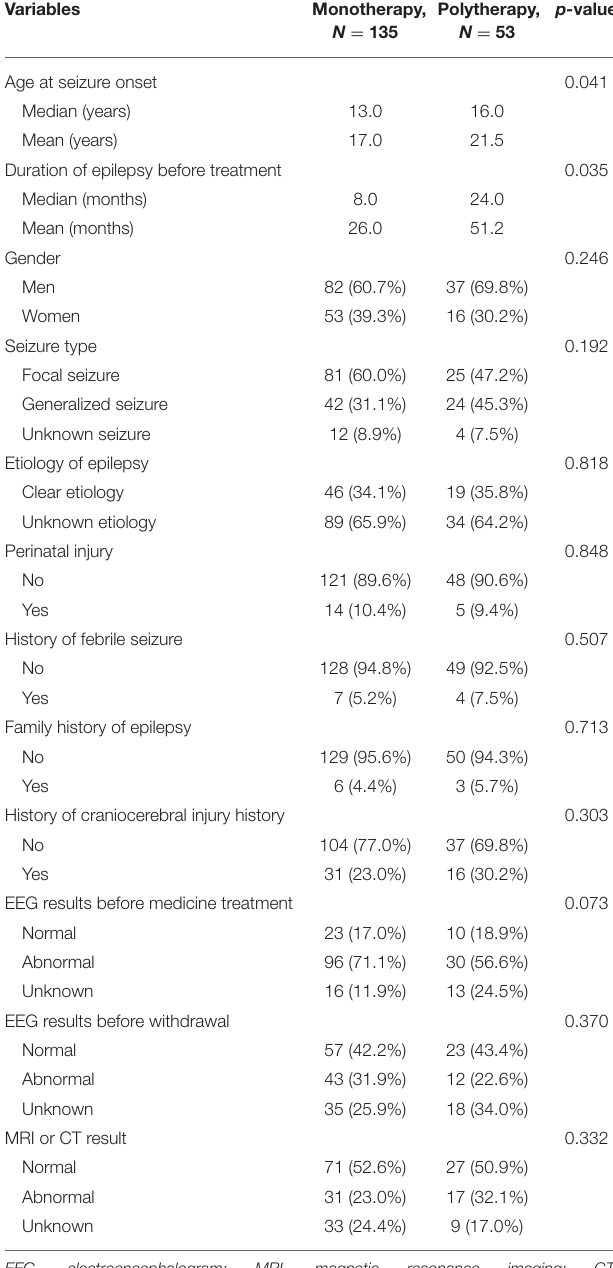
TABLE 1 | Univariate analysis of the demographic and clinical characteristics of patients treated with monotherapy and polytherapy.